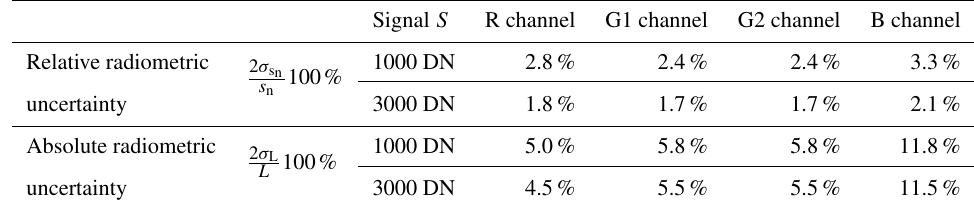
Table 3. HaloCam RAW total radiometric uncertainty with a 2 σ confidence